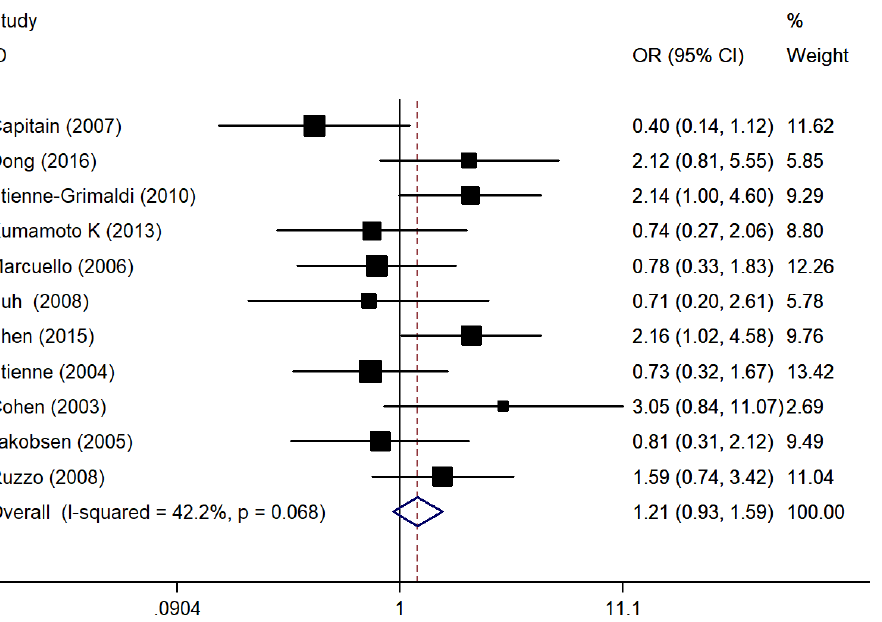
Figure 2: Forest plot of MTHFR gene rs1801133 C>T polymorphisms and chemosensitivity of colorectal cancer in dominant genetic model [(CT+TT) vs